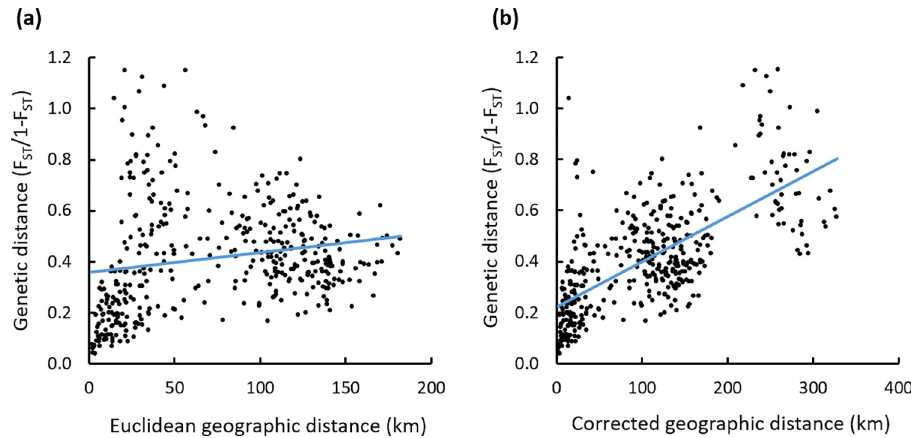
Fig 7. Isolation by distance analysis over Alytes obstetricans / almogavarii population pairs from the Pyrenees. Isolation by distance was calculated based on (a) Euclidean geographic distance between all pairs of populations (Mantel’s R = 0.185, P = 0.002) and (b) corrected geographic distance as suggested by PCA analysis, i.e. following a ring-shaped distribution around the Pyrenean chain (Fig 5; Mantel’s R = 0.683, P =